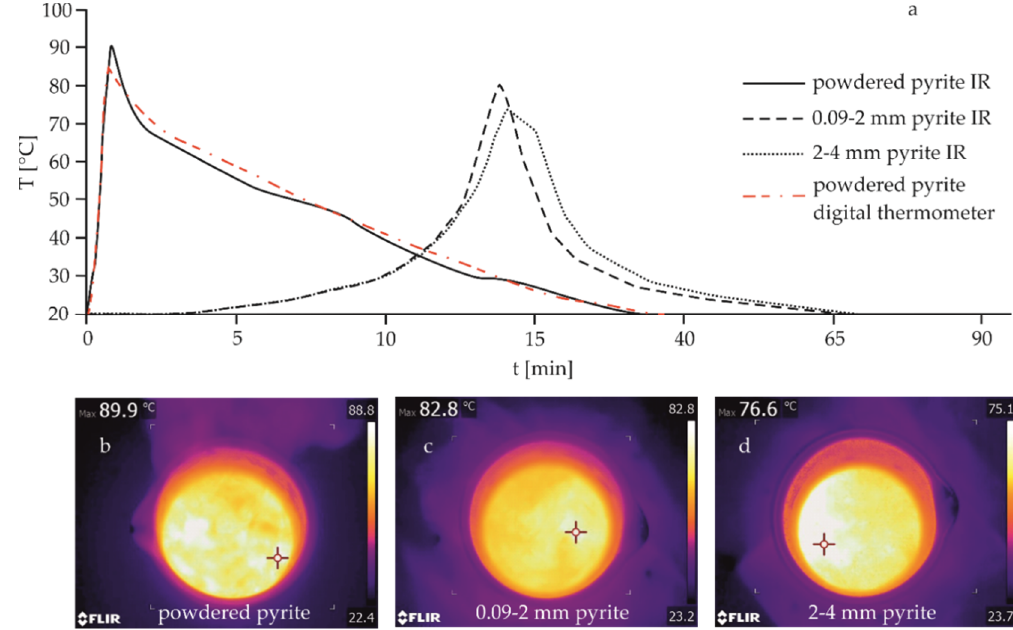
Figure 3. ( a ) Temperature–time graphs for powdered and sieved pyrite samples as measured using the IR camera and a digital thermometer. ( b – d ) IR thermography images of the temperature maxima ( T max ) for the powdered and sieved pyrite samples as measured using the IR camera. Minerals 2020 , 10 , x FOR PEER REVIEW 9 of 21